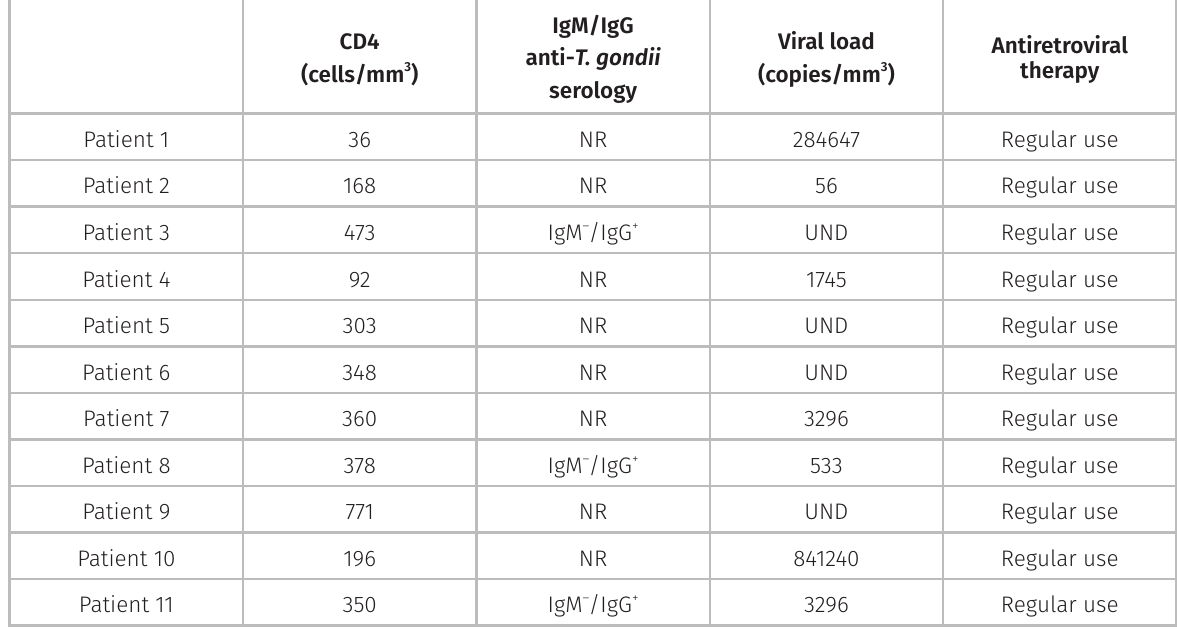
Table VII. Clinical and serological features of HIV/AIDS patients with suspected or confirmed neurotoxoplasmosis in Foz do Iguaçu city, Paraná state, Brazil, in